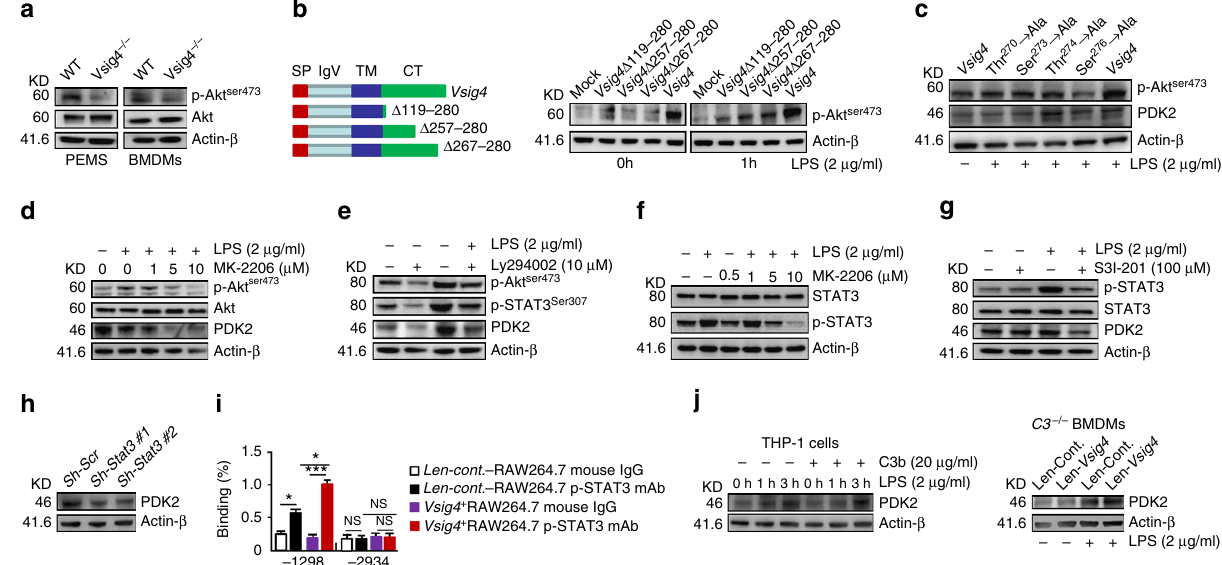
Fig. 6 VSIG4 promotes PDK2 expression through activating PI3K/Akt – STAT3. a Western blot of Akt and p-Akt ser473 expression. b RAW264.7 cells were infected with different Vsig4 deletion constructs, cells were further treated with LPS (2 μ g/ml), the expression of p-Akt ser473 was analyzed by western blot. c Western blot of p - Akt ser473 and PDK2 in VSIG4 + RAW264.7 cells with mutation of Ser 273 , Ser 276 , Thr 270 , and Thr 274 to Ala. VSIG4 + RAW264.7 cells were treated with d the Akt inhibitor MK-2206, e the PI3K inhibitor Ly294002, and the expression of Akt, p-Akt ser473 , PDK2, and p-STAT3 was detected by western blot. f VSIG4 + RAW264.7 cells were treated with the MK-2206, and the expression of STAT3/p-STAT3 was analyzed by western blot. g Western blot of p-STAT3/STAT3 and PDK2 in LPS-activated VSIG4 + RAW264.7 cells followed with STAT3 inhibitor, S3I-201 (100 μ M) treatment for 24 h. h Western blot of PDK2 in Stat3 silenced VSIG4 + RAW264.7 cells. i The enrichment of p-STAT3 in Pdk2 gene promoter region was detected by ChIP-qPCR assay. j Human VSIG4 + THP-1 cells were treated with microbeads-C3b (20 μ g/ml) in the presence of LPS (2 μ g/ml), and the expression of PDK2 was detected by western blot. Moreover, C3 − / − BMDMs were transfected to overexpress VSIG4, and cells were further treated with LPS (2 μ g/ml) for an additional 3 h, and the expression of PDK2 was detected by western blot. Error bar, s.e.m. * p < 0.05, *** p < 0.0001 and NS, p > 0.05 (Student ’ s t